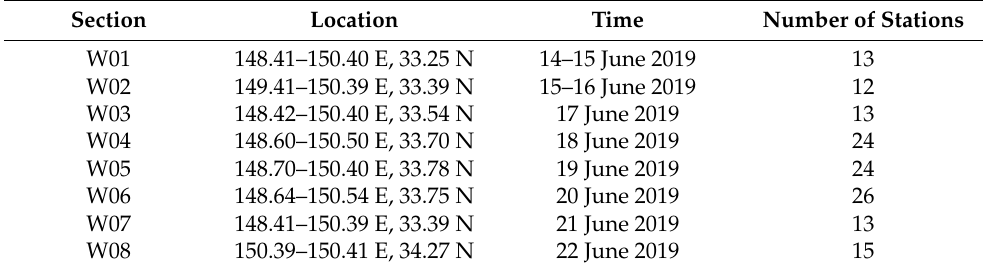
Table 1. Locations of stations along each